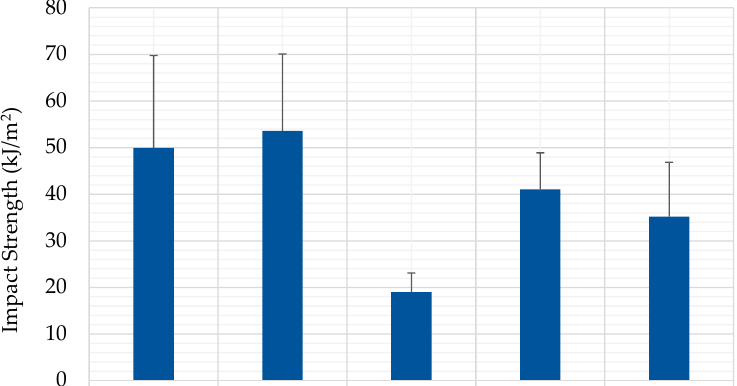
Figure 10. Impact strengths of the tested composites.